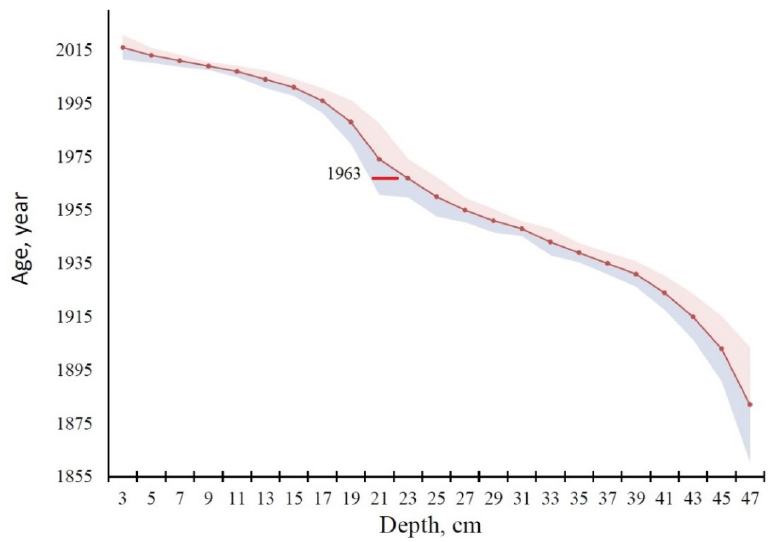
Figure 5. The results of 210 Pb chronology for the ISNO-1 peat core according to the CF model using the Monte Carlo method .